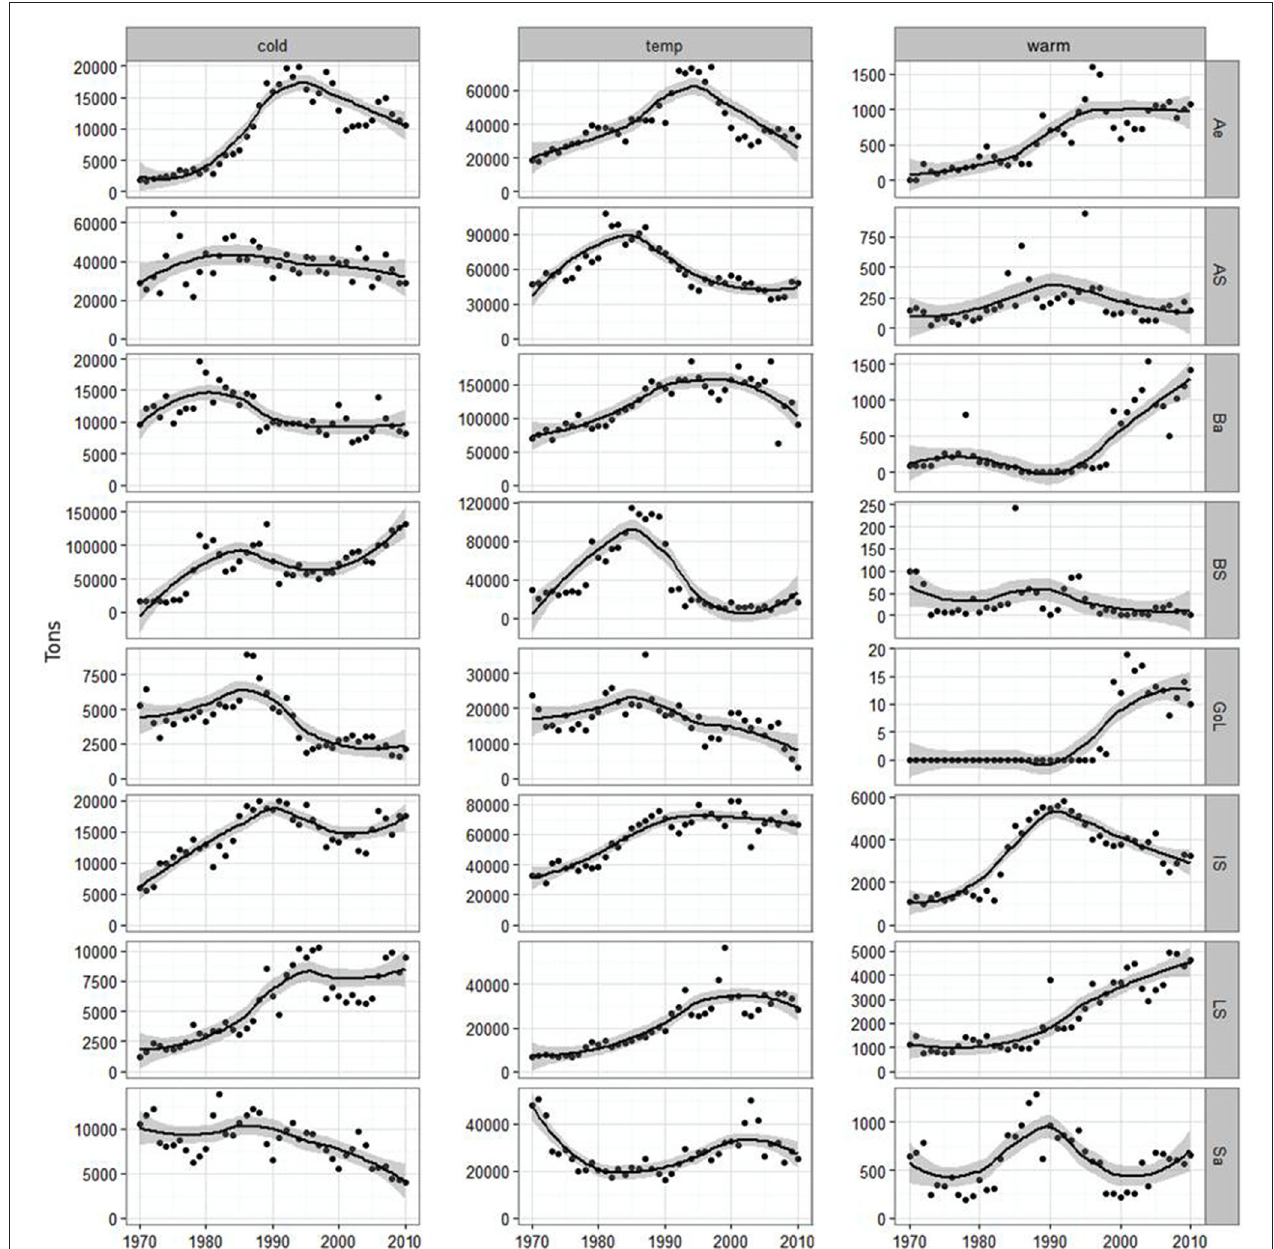
FIGURE 2 | Temporal tends of the three thermal affinity groups landings in the eight FAO-areas. Ae, Aegean Sea; AS, Adriatic Sea; Ba, Balearic Sea; BS, Black Sea; GoL, Gulf of Lion; IS, Ionian Sea; LS, Levantine Sea; Sa, Sardinia; dots represent the landing values, the line is the loess smoothed fitting, and the gray bands indicate 95% pointwise confidence